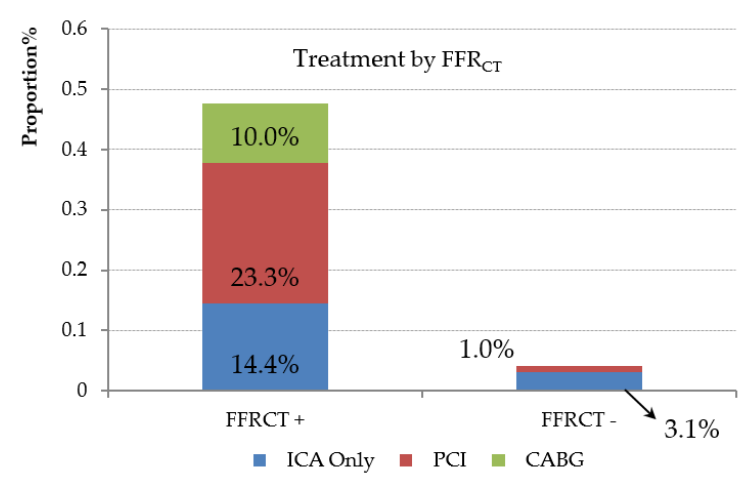
Figure 4. Outcome of invasive coronary angiography (ICA) or revascularization with percutaneous coronary intervention (PCI) or coronary artery bypass graft surgery (CABG) according to fractional flow reserve derived from coronary computed tomographic angiography (FFR CT ) positivity. For patients who underwent coronary CTA and selective FFR CT, there were no adverse events in a